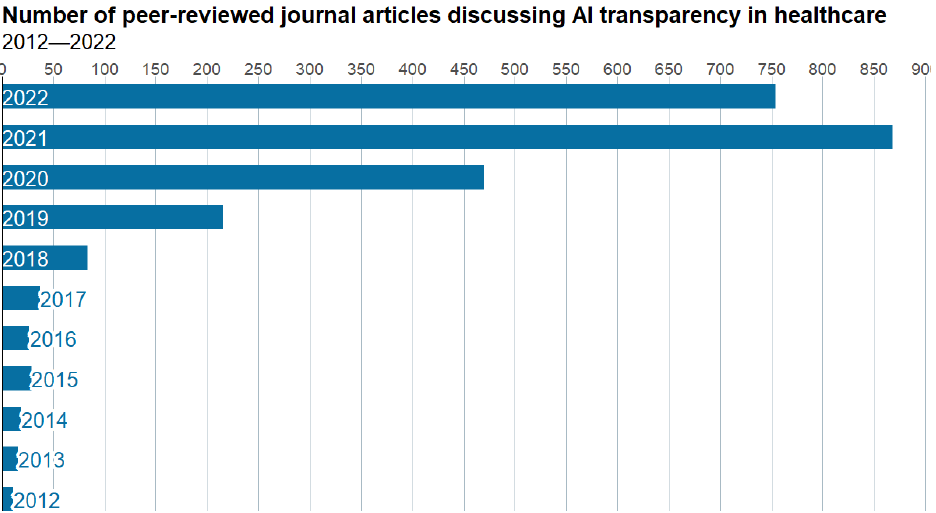
Figure 1. Number of peer-reviewed journal articles discussing AI transparency in healthcare. Using the Web of Science, we searched and counted the works containing (Transparency, Ethics, Equity, Interpretability, Explainability, Security, Privacy, Intellectual property, Trust, Reliability) and (Health- care, Medicine, Diagnosis, Prognosis, Prediction, Health, Care, Medical) and (Artificial intelligence) in their